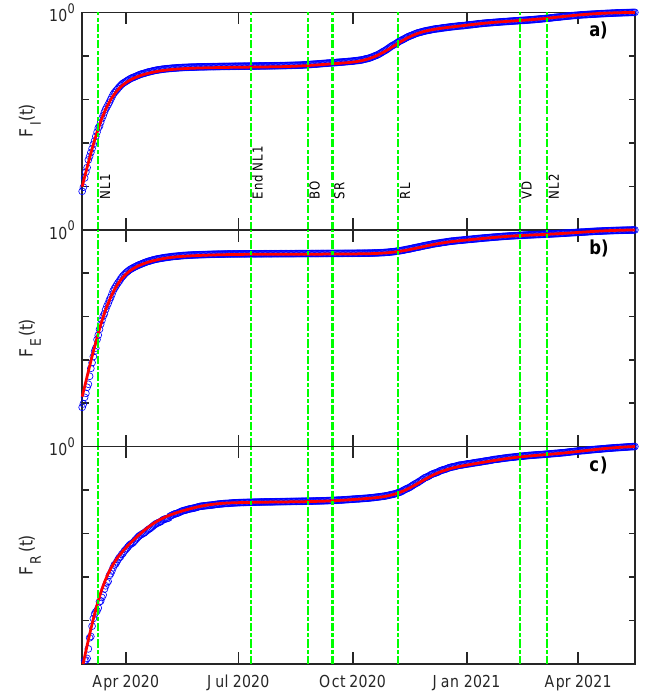
Figure 5. ( a ) Infected, ( b ) deceased and ( c ) recovered cumulative distribution functions. Blue open circles correspond to raw data, while the red solid lines represent model curves (Equations (22)–(24)).